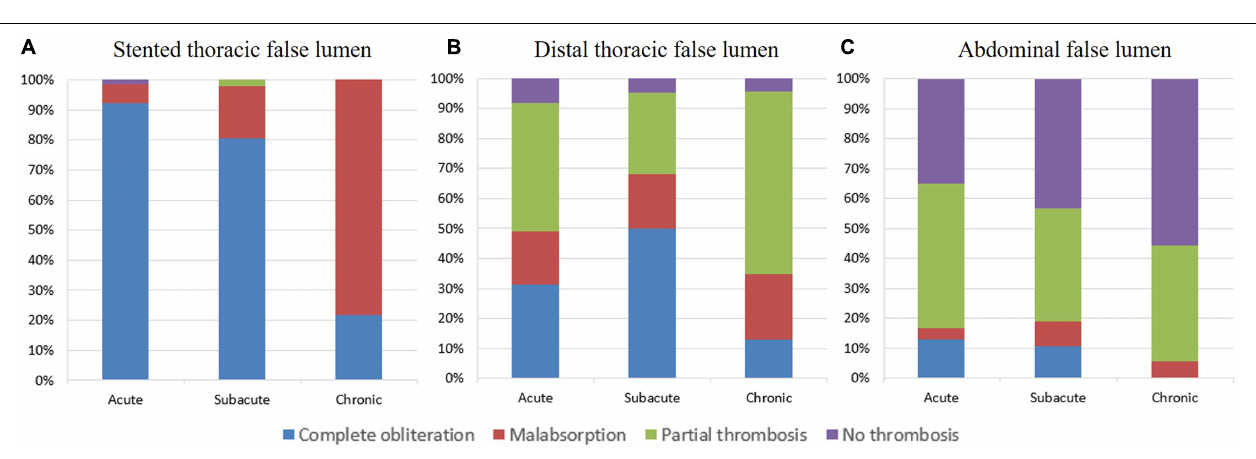
Frontiers in Cardiovascular Medicine |